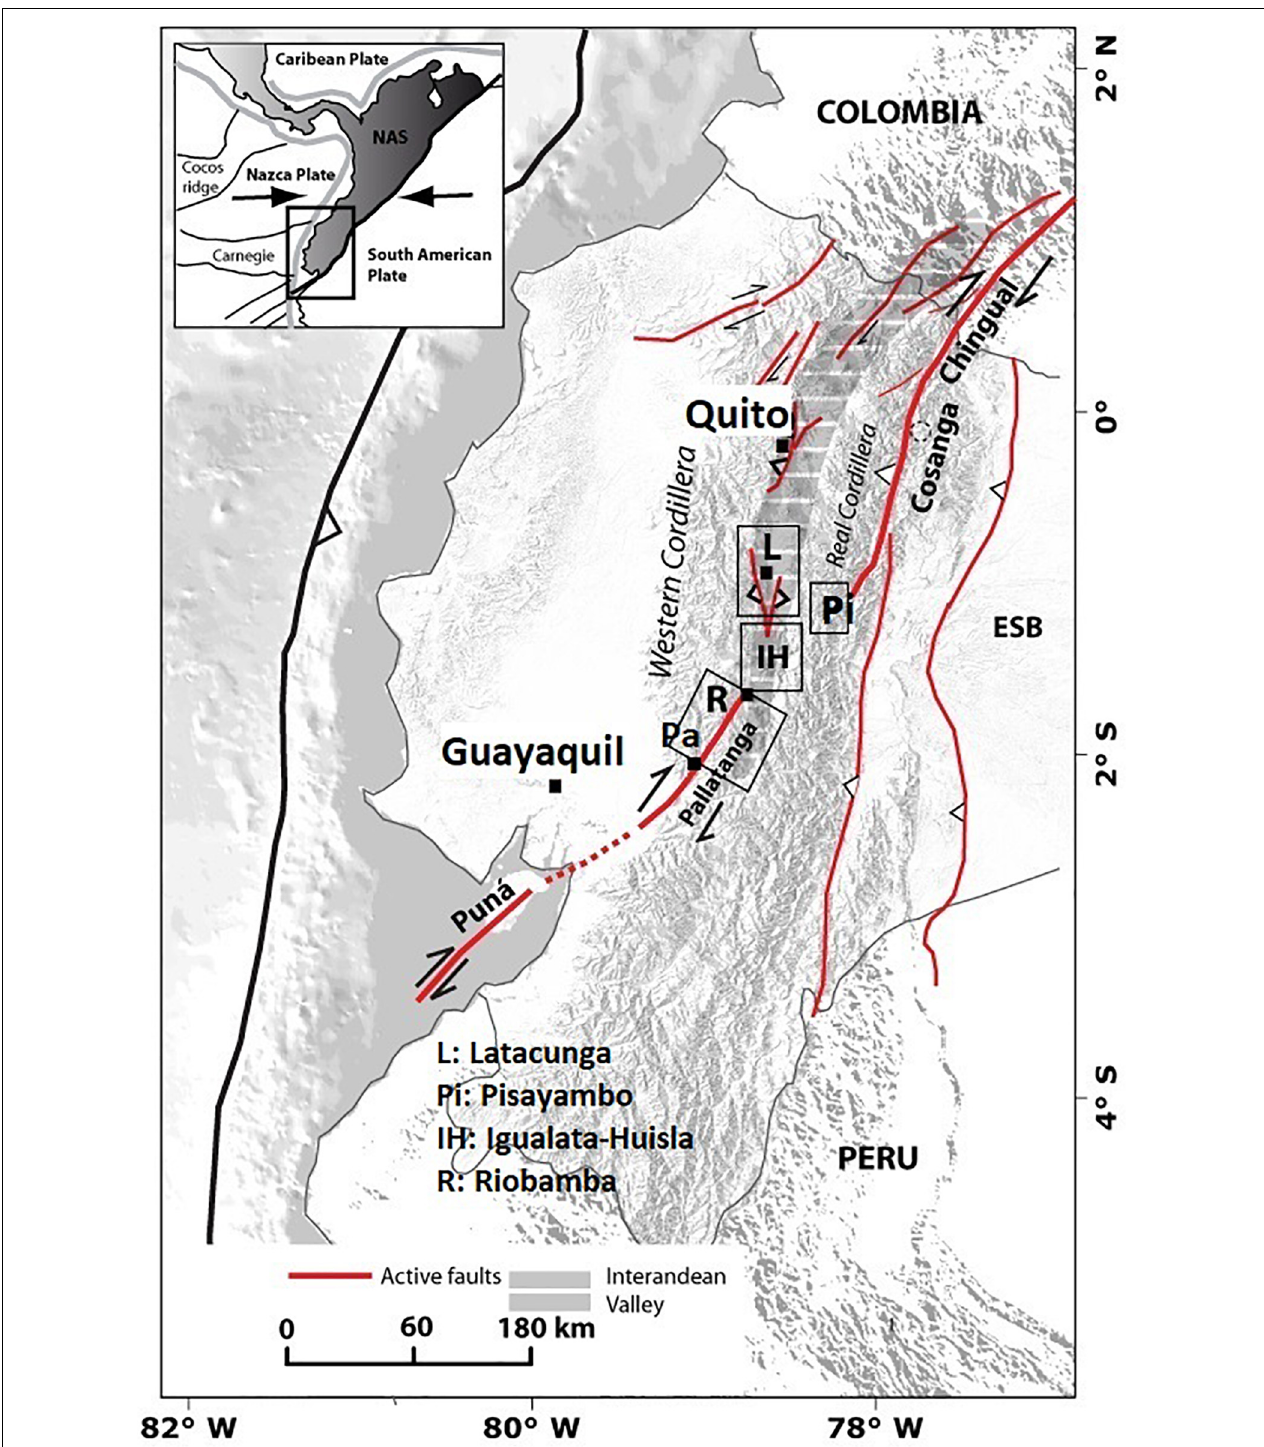
FIGURE 1 | Location of the investigated area in its tectonic context. Upper left inset gives a general geodynamic overview illustrating the major role of the CCPP (Chingual Cosanga Pallatanga Puna) fault zone acting as a boundary between the South America Plate and the North Andean Sliver (NAS) (Modified from Alvarado et al., 2016) in gray. The major active faults are the bold red lines; the investigated sectors are the Pallatanga fault north of Pallatanga (Pa) and south of Riobamba (R), the fault segments cutting the Igualata and Huisla volcanoes (IH) and the fault continuation around the Laguna Pisayambo (Pi) and the fault-related folds nearby Latacunga (L). (I) is Ibarra. The offshore bold line represents the subduction trench location, more than 100 km west of the Puna segment fault. ESB: Eastern Subandean Belt.